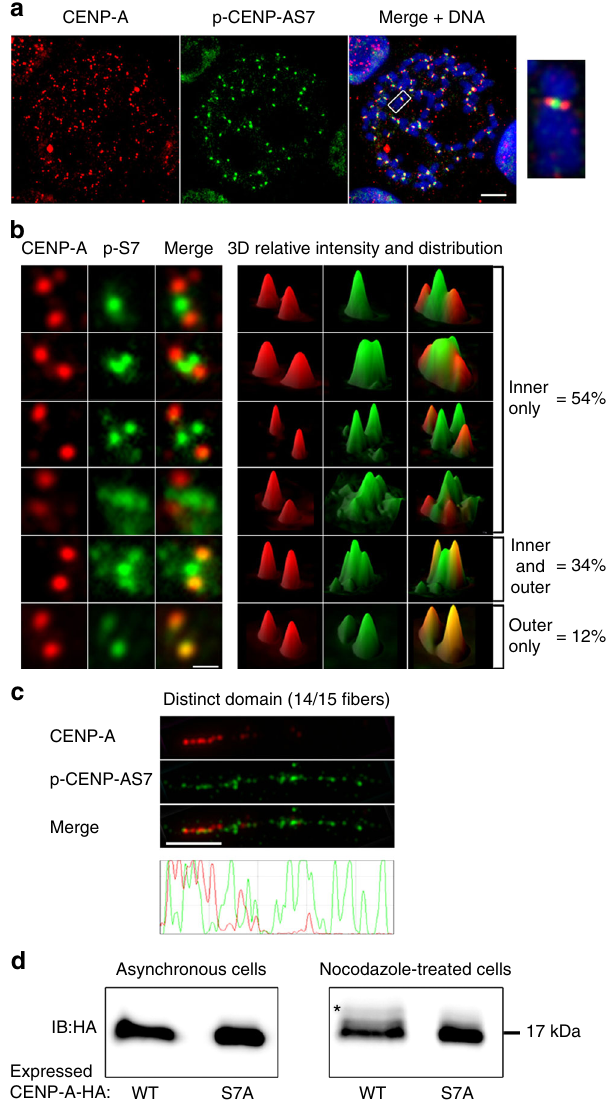
staining (blue), scale bar = 10 µ m. Magni fi cation × 7.5 of a single chromosome. b Distribution of p-CENP-AS7 (green) and CENP-A (red) at centromeres. Left panels: different patterns of immuno fl uorescence signals with p-CENP-AS7 on the inner side only, on both the inner and outer sides and on the outer side only; right panels: 3D views of p-CENP-AS7 (green) and CENP-A (red) signals. Scale bar = 1 µ m. In total, 520